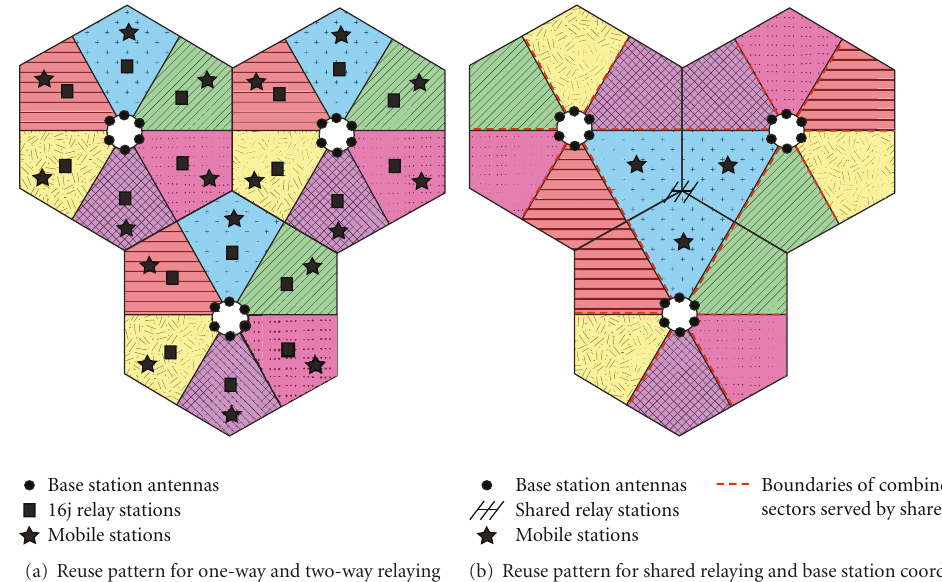
Figure 2: Frequency reuse patterns with reuse 6 for (a) one-way and two-way relaying and (b) shared relaying and base station coordination.